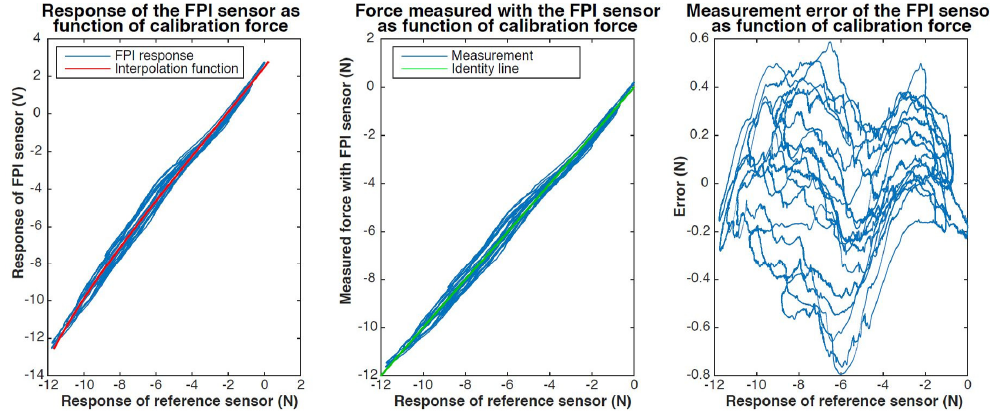
Figure 12. Results of dynamic calibration of a prototype of the Invar capillary concept. The response of the FPI as function of the calibration force, together with a fitted third order polynomial interpolation function, is shown on the left. The graph in the center shows the force measured with the FPI-based sensor, calculated using the interpolation function, as function of the calibration force and the indentity line ( y = x ) as a reference. The measurement error of the FPI-based sensor as function of the calibration force is shown on the